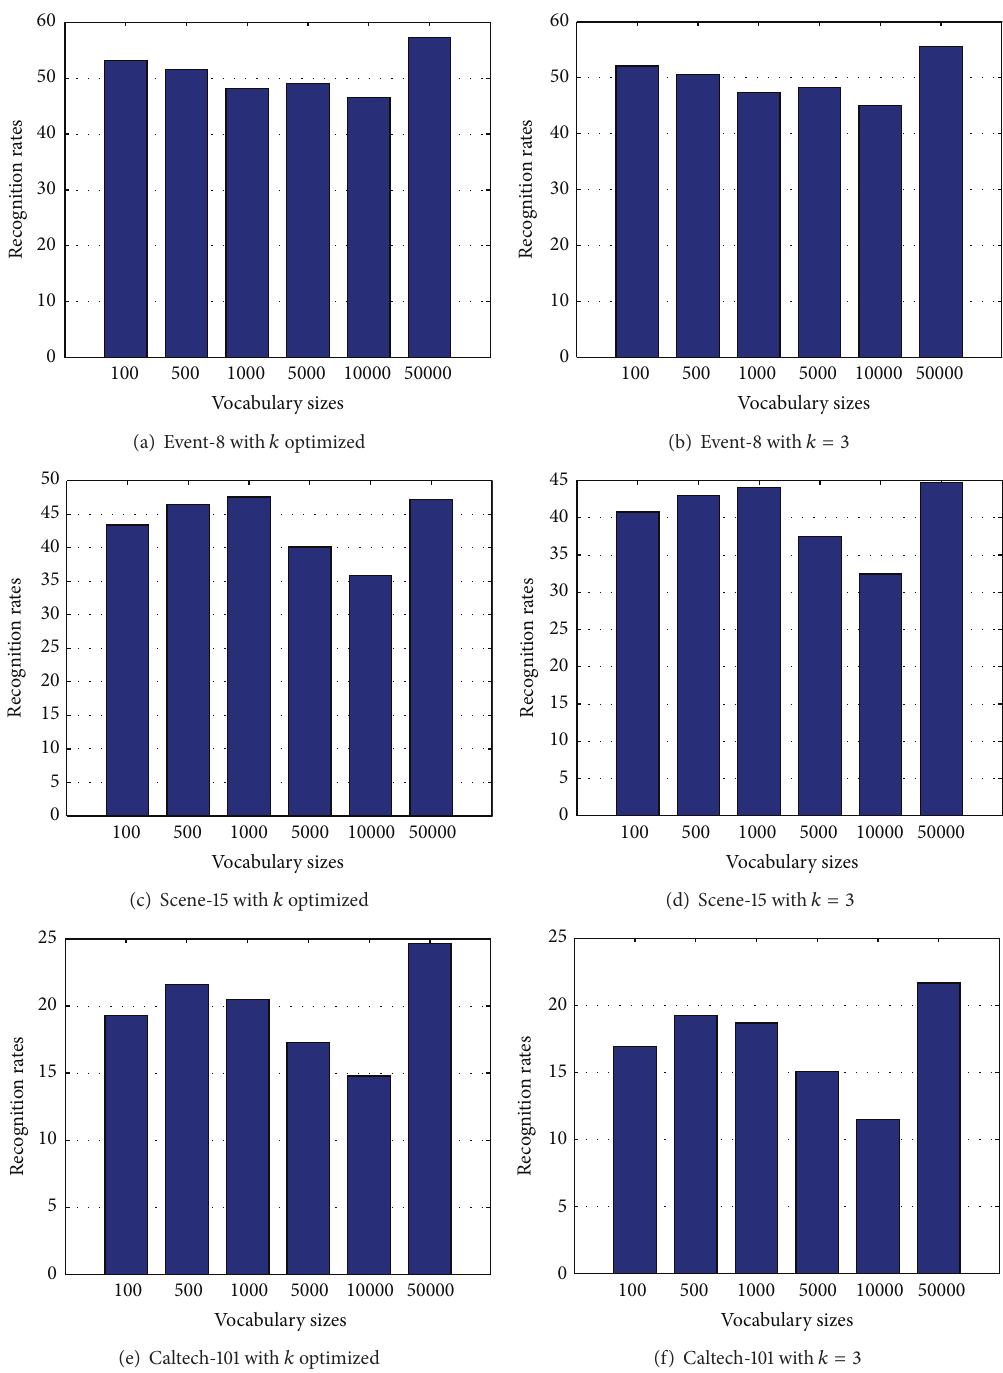
Figure 1: The relationship between classification rates and vocabulary sizes, with 𝑘 optimized and 𝑘 = 3 .